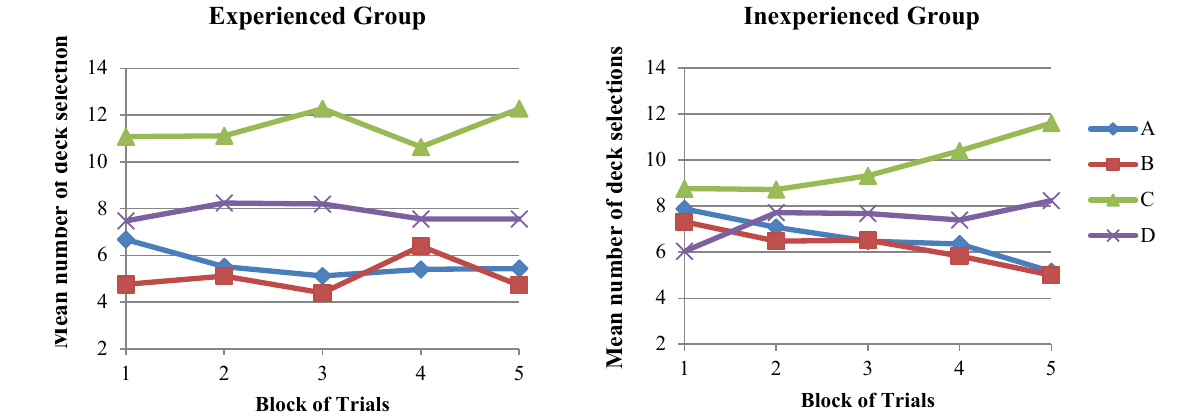
Fig. 5. Deck selection criteria for (A) Experienced, and (B) Inexperienced